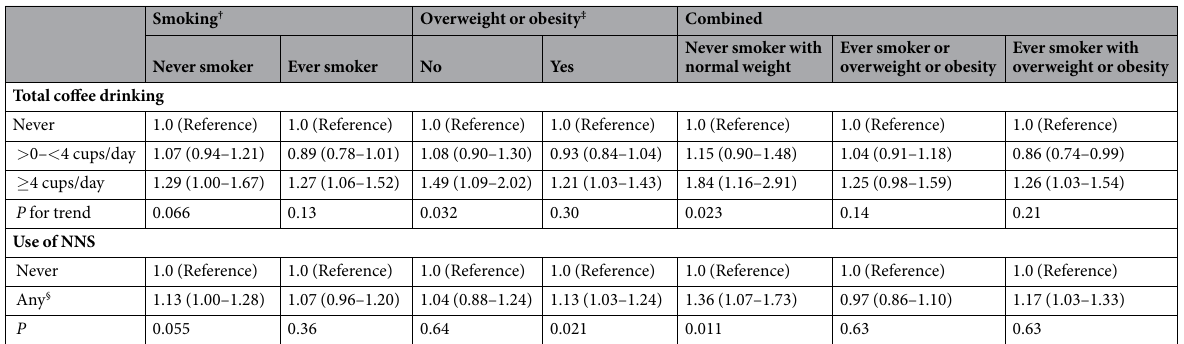
Table 6. Multivariable adjusted odds ratios (95% confidence intervals) for depression according to total coffee drinking and non-nutritive sweeteners use among participants with different smoking status and BMI levels (n = 17894) * . NNS = non-nutritive sweetener. * Adjusted for age, sex, ethnicity, education, province of residence, alcohol drinking, smoking (where applicable), self-reported cardiovascular disease and diabetes, healthy eating index (in tertiles), total physical activity (in MET-min/week tertiles), and BMI as well as mutually controlled for coffee drinking and sweeteners use. † Smoking status: never/ever smoker. ‡ Overweight or